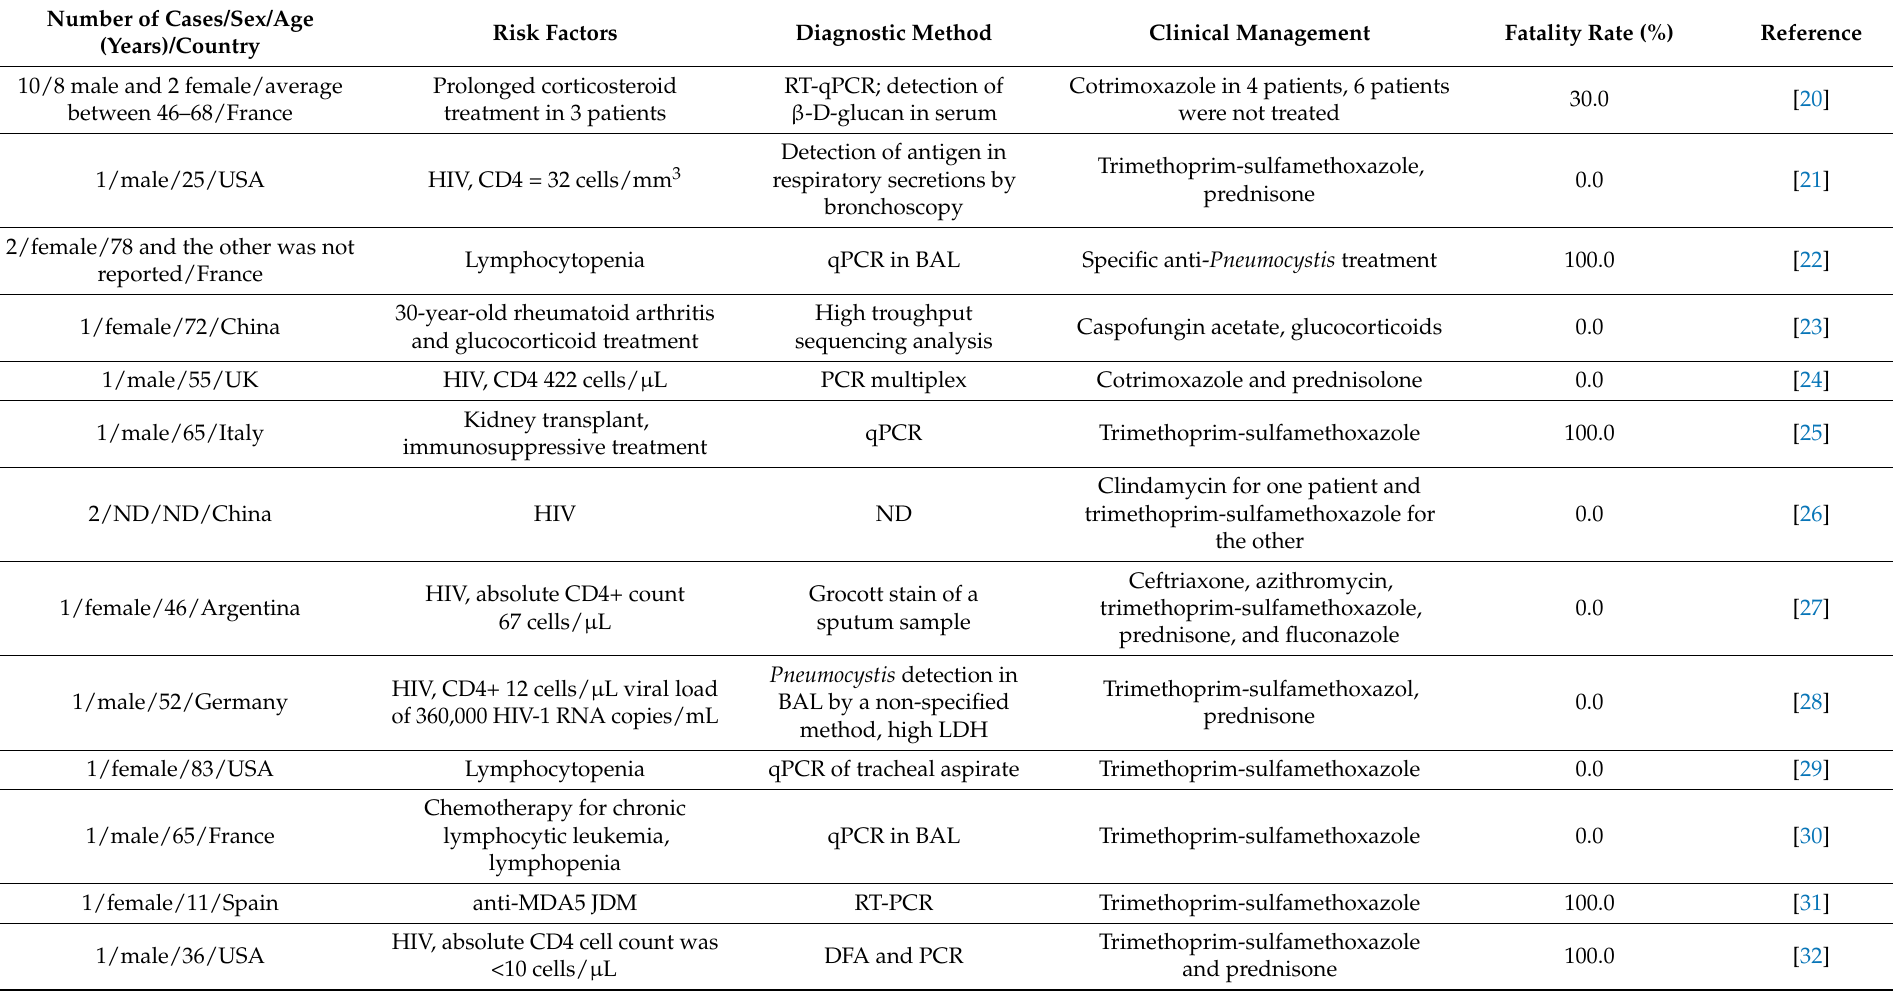
Table 1. Cases of COVID-19 and Pneumocystis jirovecii